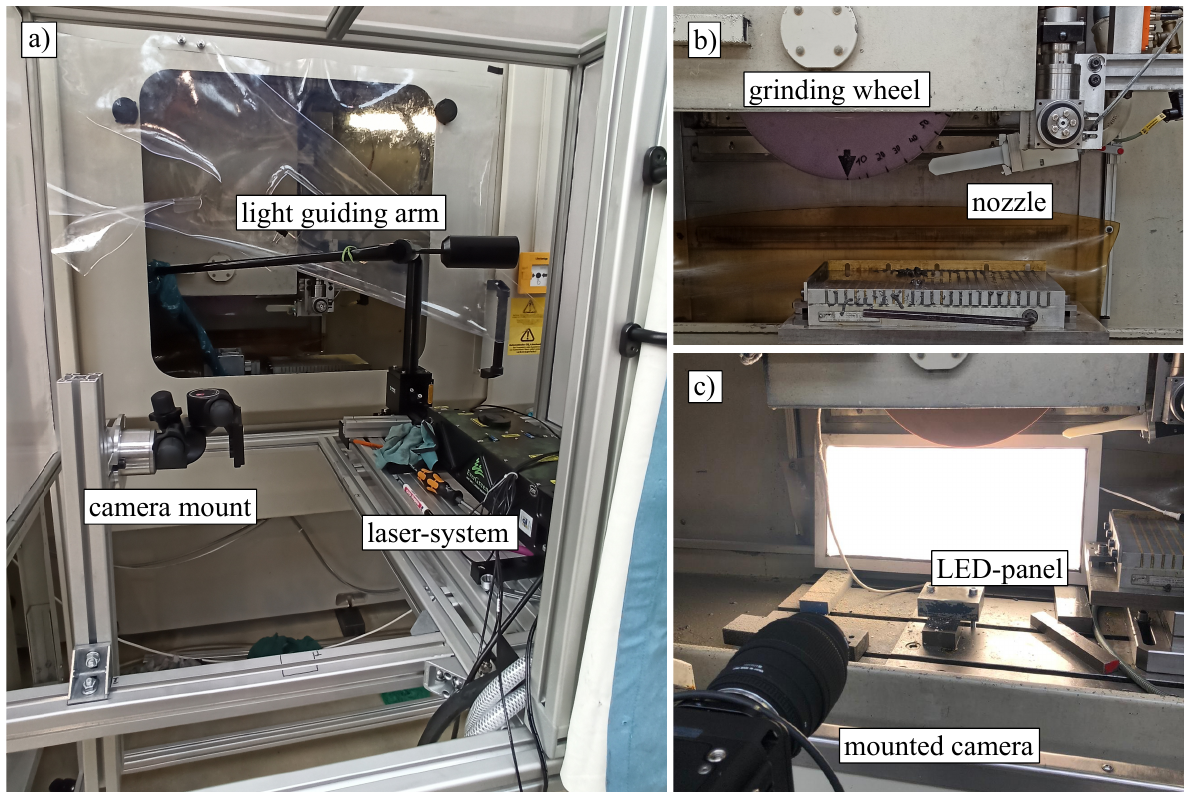
Figure 4. Used experimental flow measurement setup in the grinding machine: ( a ) setup in the protective housing, where the optical components such as the laser, light guiding arm and camera are installed; ( b ) arrangement of the grinding wheel and nozzle in the grinding machine; ( c ) setup for SIV measurements, consisting of the mounted camera and the LED